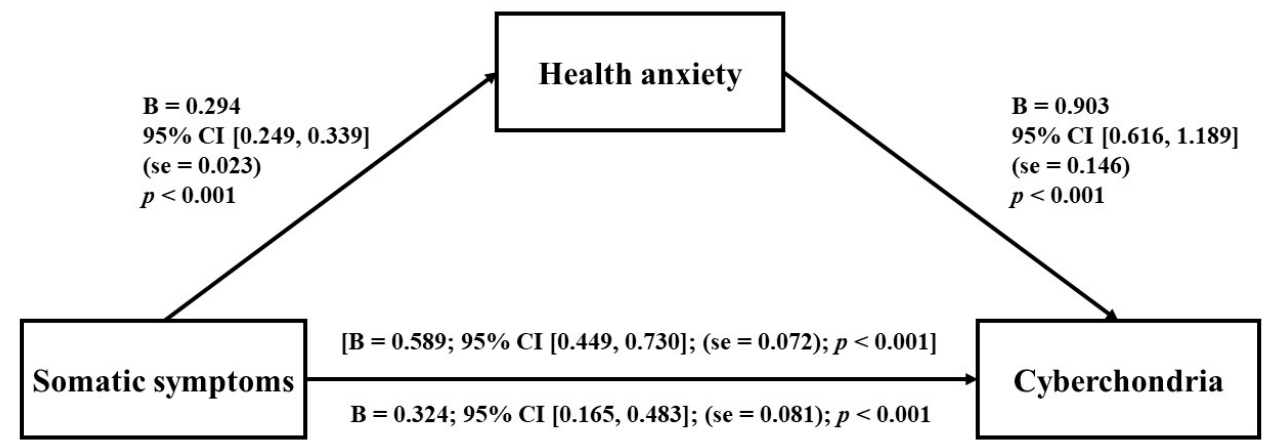
Figure 1. Mediating effects of health anxiety on the relationship between somatic symptoms and cyberchondria.